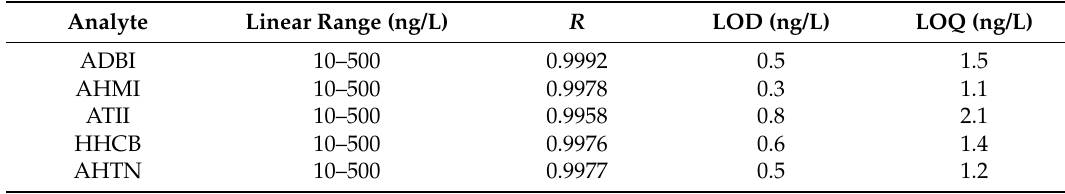
Table 1. Analytical parameters for PCM determination using GC–MS/MS.